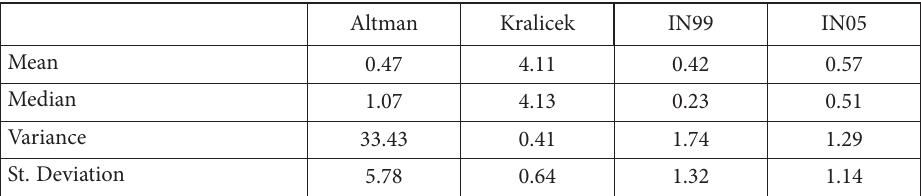
Table 10. Results for all enterprises 3 years before (source: authors based on financial statements) Altman Kralicek IN99 IN05 Mean 0.47 Median Variance 33.43 1.29 St.